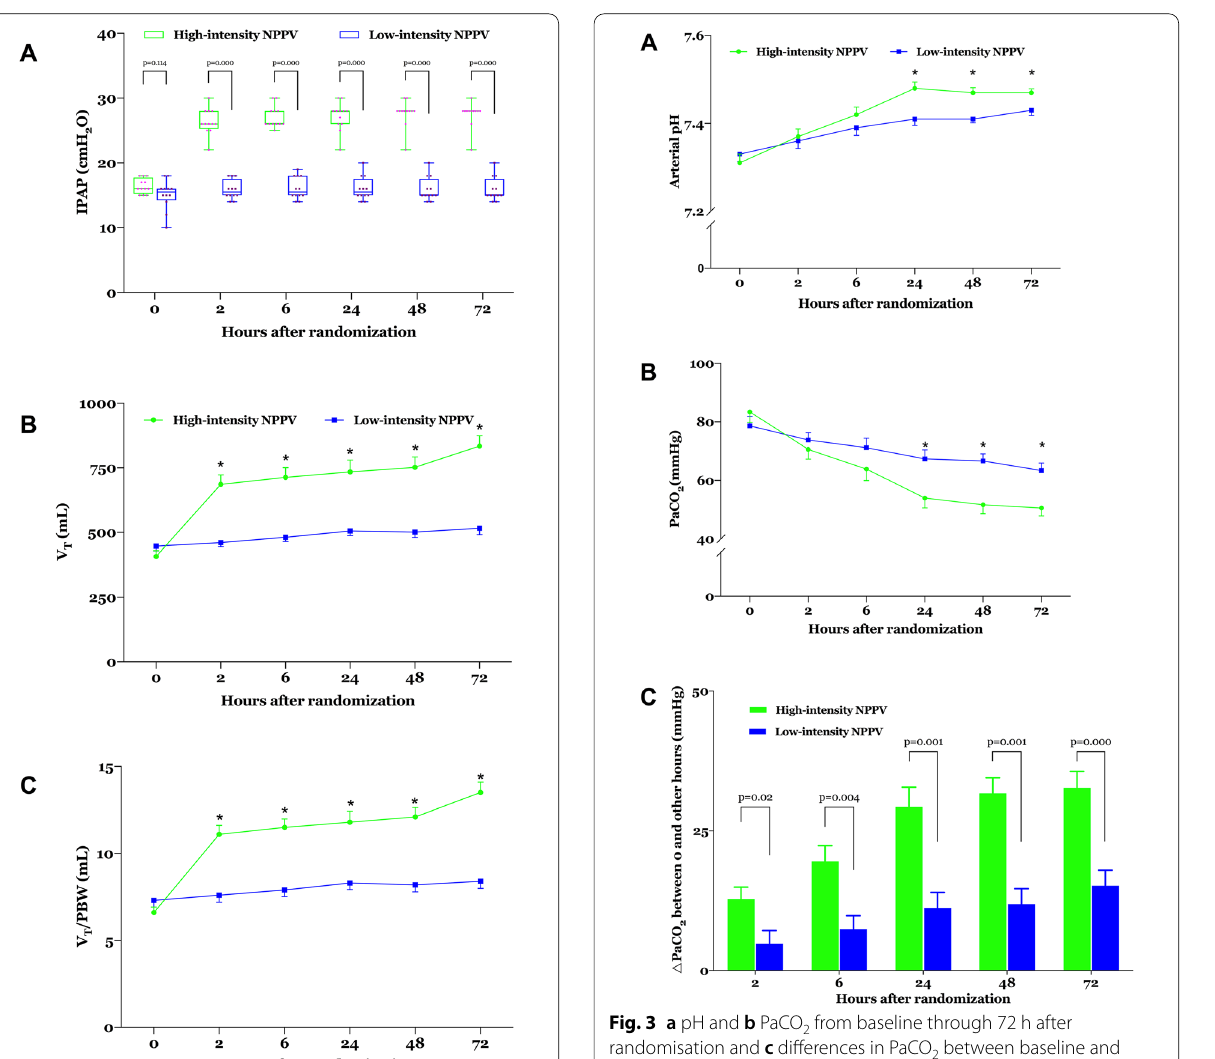
Fig. 2 a IPAP, b V T , and c V T /PBW from baseline through 72 h after randomisation. Values are individuals, medians, and interquartile ranges with whiskers indicating minimum and maximum for IPAP and means and standard errors for V T and V T /PBW. * p < 0.05 between the two groups at the same time. NPPV noninvasive positive pressure ventilation, IPAP inspiratory positive airway pressure, V T tidal volume, PBW predicted body weight